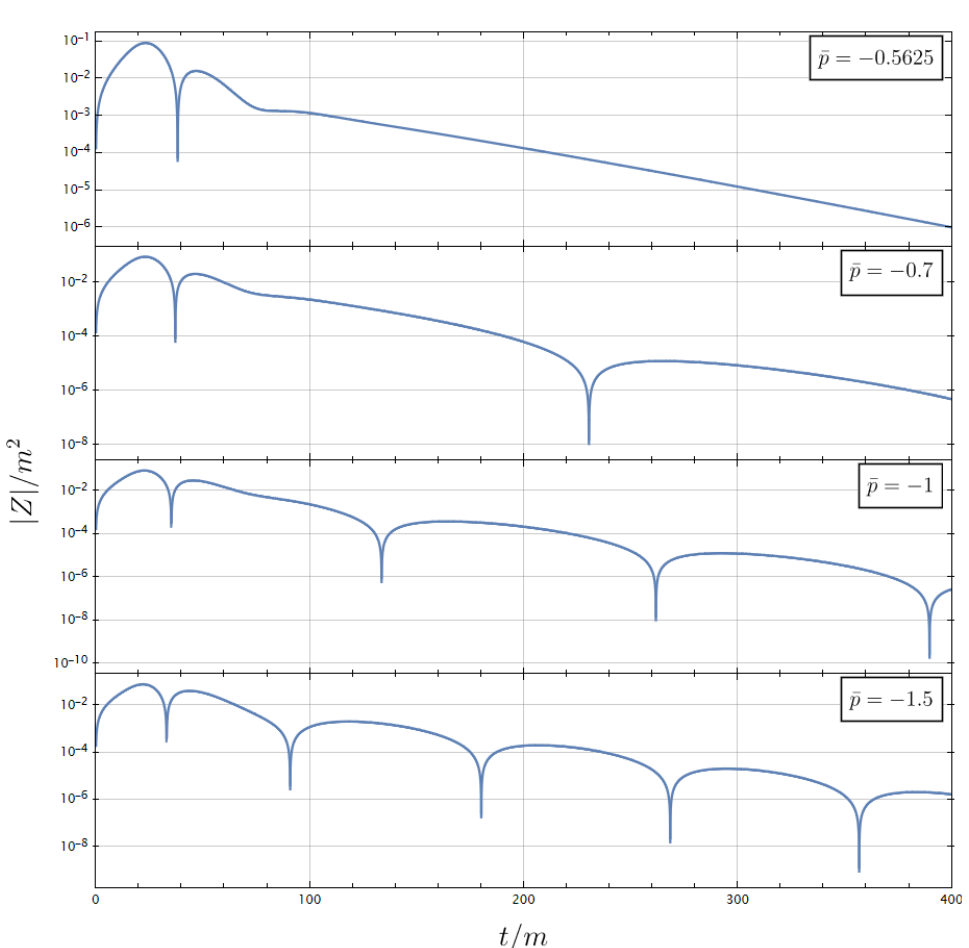
Figure 2 . Evolution of | Z | /m 2 as a function of t/m at fixed radius, for ‘ = 0 and different values of ¯ p , showing the onset of the oscillatory regime in the late-time region for ¯ p < − 9 / 16 = − 0 . 5625 . The cosmological constant is set to Λ = 0 . 001 /m 2